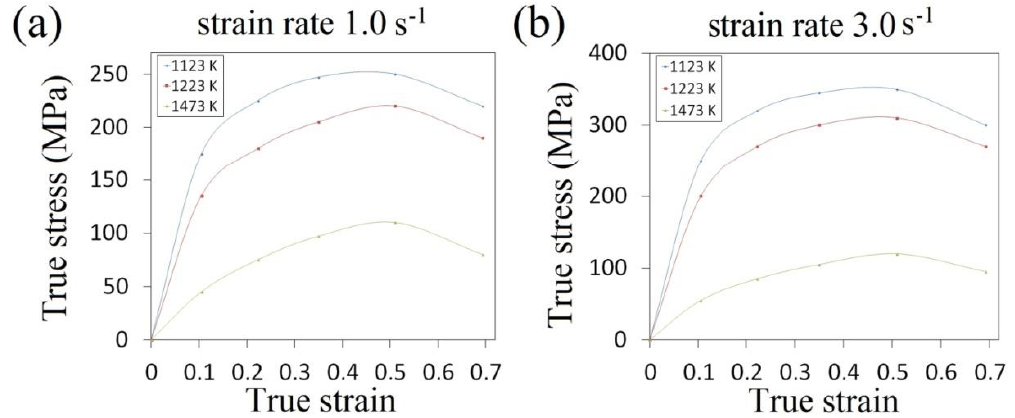
Figure 1. The relationships between true stress and true strain for X32CrMoV12-28: ( a ) strain rate 1.0 s − 1 ; ( b ) strain rate 3.0 s − 1 .